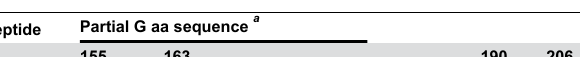
Peptide Partial G aa sequence a G-A2 FHFEVFNFVPCSICSNNPT CWAIC KRIP a G-A2 peptide amino acid sequence is from the RSV group A strain A2. The location of the CX3C motif in the G peptides is underlined. The amino acid sequence (393-405) for the L control peptide is IINGRWIILLSKFLK. doi: Peptides